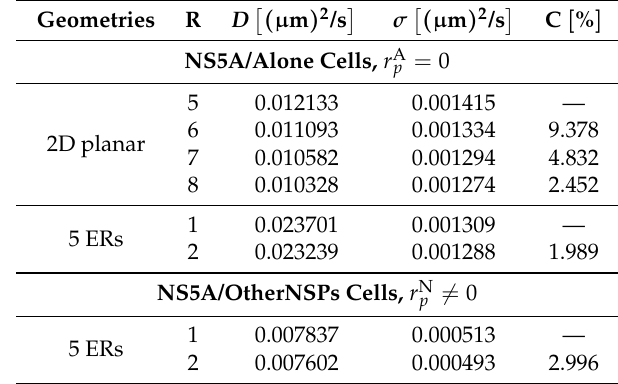
Table A4. Refinement stability: Averaged NS5A diffusion constant for the simplified planar 2D case and the ER surface manifold computations (using only one FRAP ROI per ER geometry. Nota bene: the afore reported final results cover all geometric setups, i.e., the final results reported in Table 1 are based upon the use of two FRAP ROIs per reconstructed ER geometry). Evaluation for different spatial refinement levels R of base geometry and relative change C in comparison to level before in percentage. Values for the NS5A/Alone cell case without pseudo reaction, i.e., r A p = 0 in (8) and for the